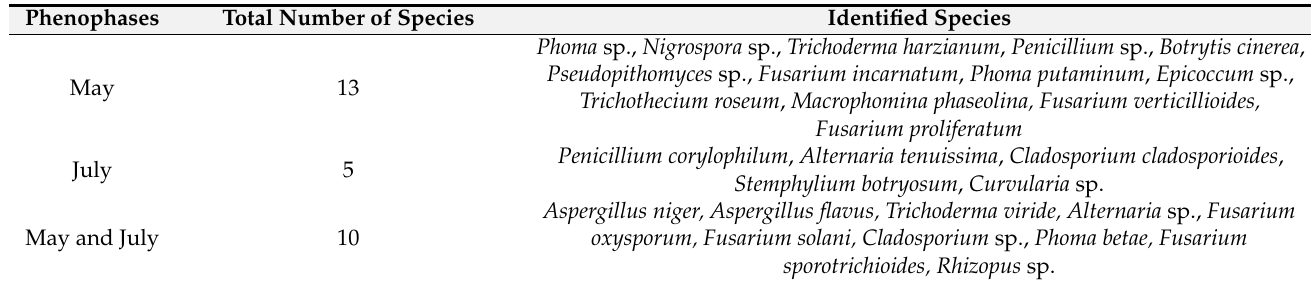
Table 1. Fungal isolates from ‘Williams’ pear variety’s